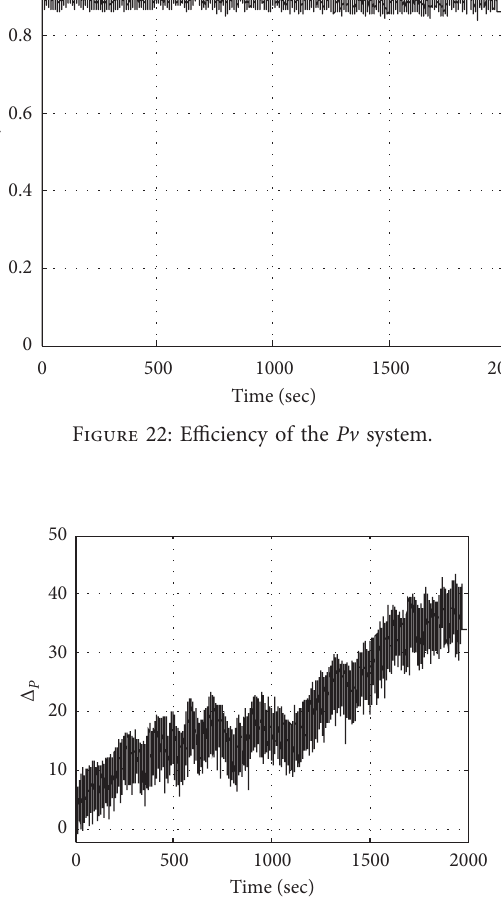
Figure 23: Evolution of “DeltaP” of current control.